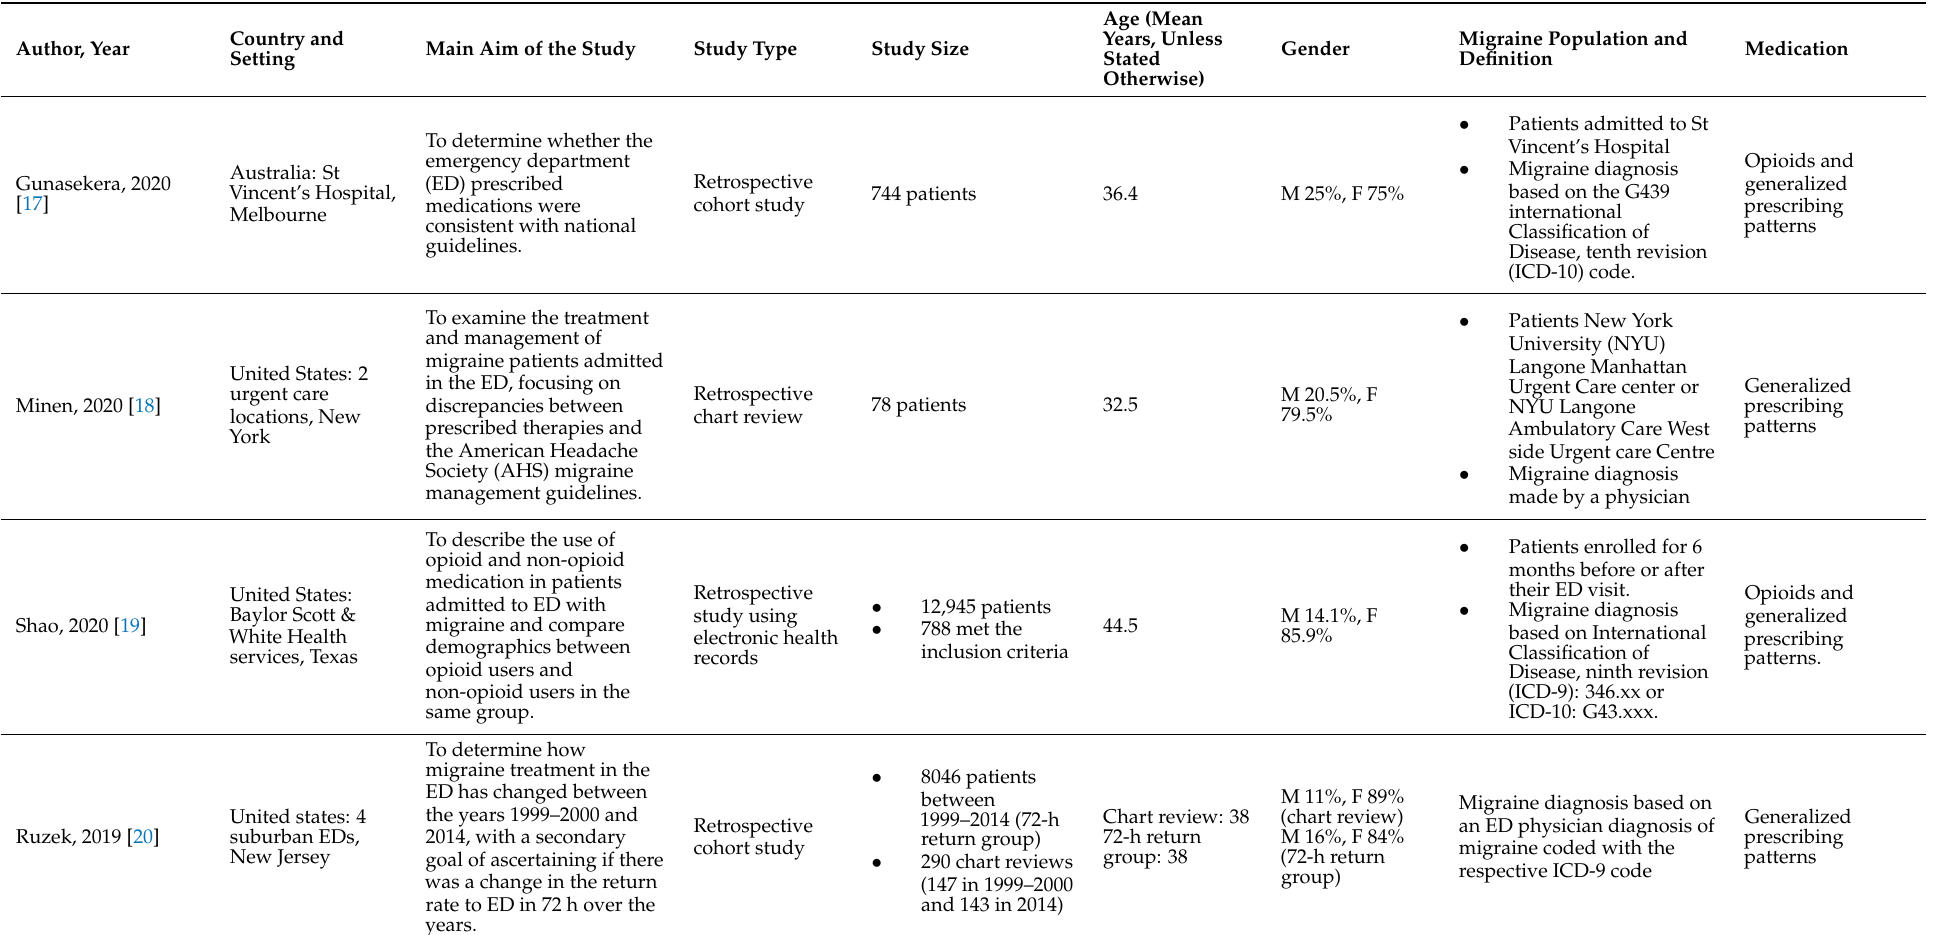
Table 1. Characteristics of included